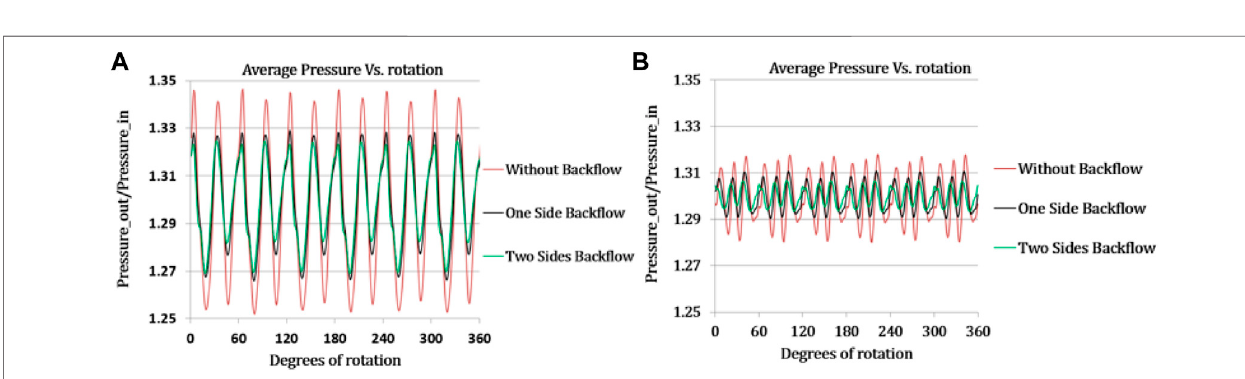
Frontiers in Mechanical Engineering |